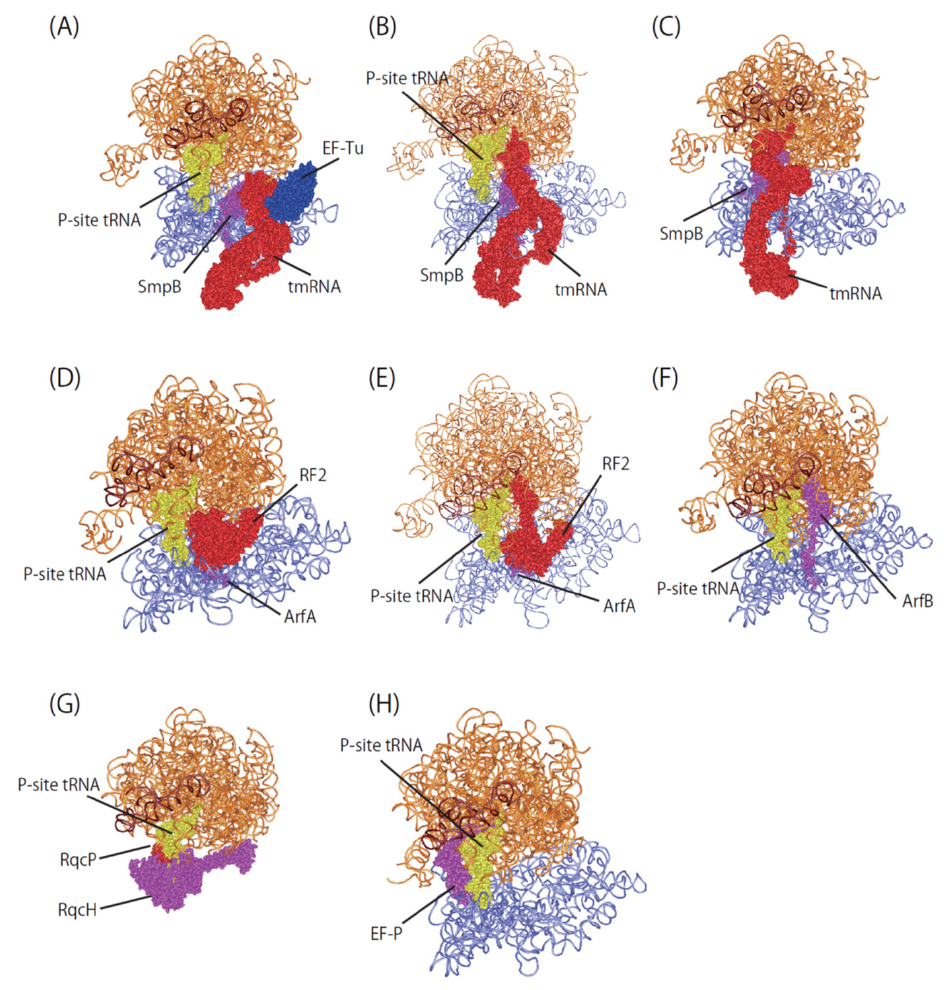
Figure 3. Overview of ribosome rescue factor complexes. ( A ) Pre-accommodation complex of Ala- tmRNA·SmpB·EF-Tu·GDP·kirromycin with 70S ribosome (PDBID:7ABZ). ( B ) Accommodation com- plex of tmRNA·SmpB with 70S ribosome (PDBID:7AC7). ( C ) Translocated complex of tmRNA·SmpB with 70S ribosome (PDBID:7ACJ). ( D ) Pre-accommodated complex of ArfA (A18T)/RF2 with 70S ribosome (PDBID:5MDW). ( E ) Accommodated complex of ArfA/RF2 with 70S ribosome (PDBID:5MDV). ( F ) ArfB complex with 70S ribosome (PDBID:6YSS). ( G ) RqcH/RqcP com- plex with 50S subunit (PDBID:7AS8). ( H ) EF-P complex with 70S ribosome (PDBID:6ENU).